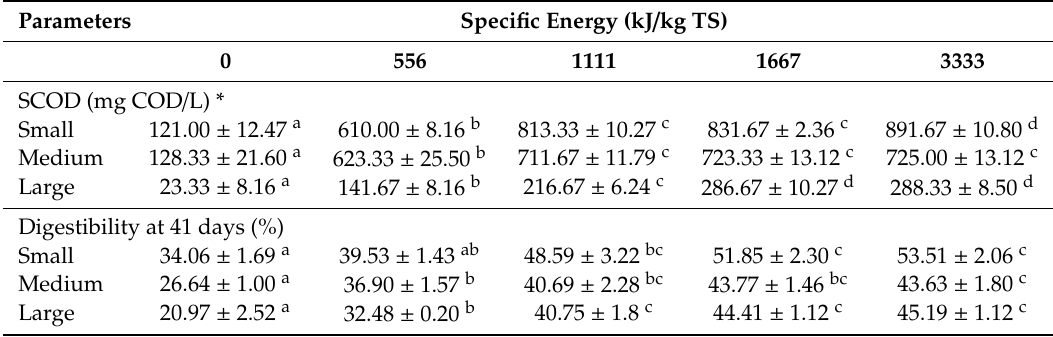
Table 2. Soluble chemical oxygen demand (SCOD) and digestibility of Napier grass silage after sonication